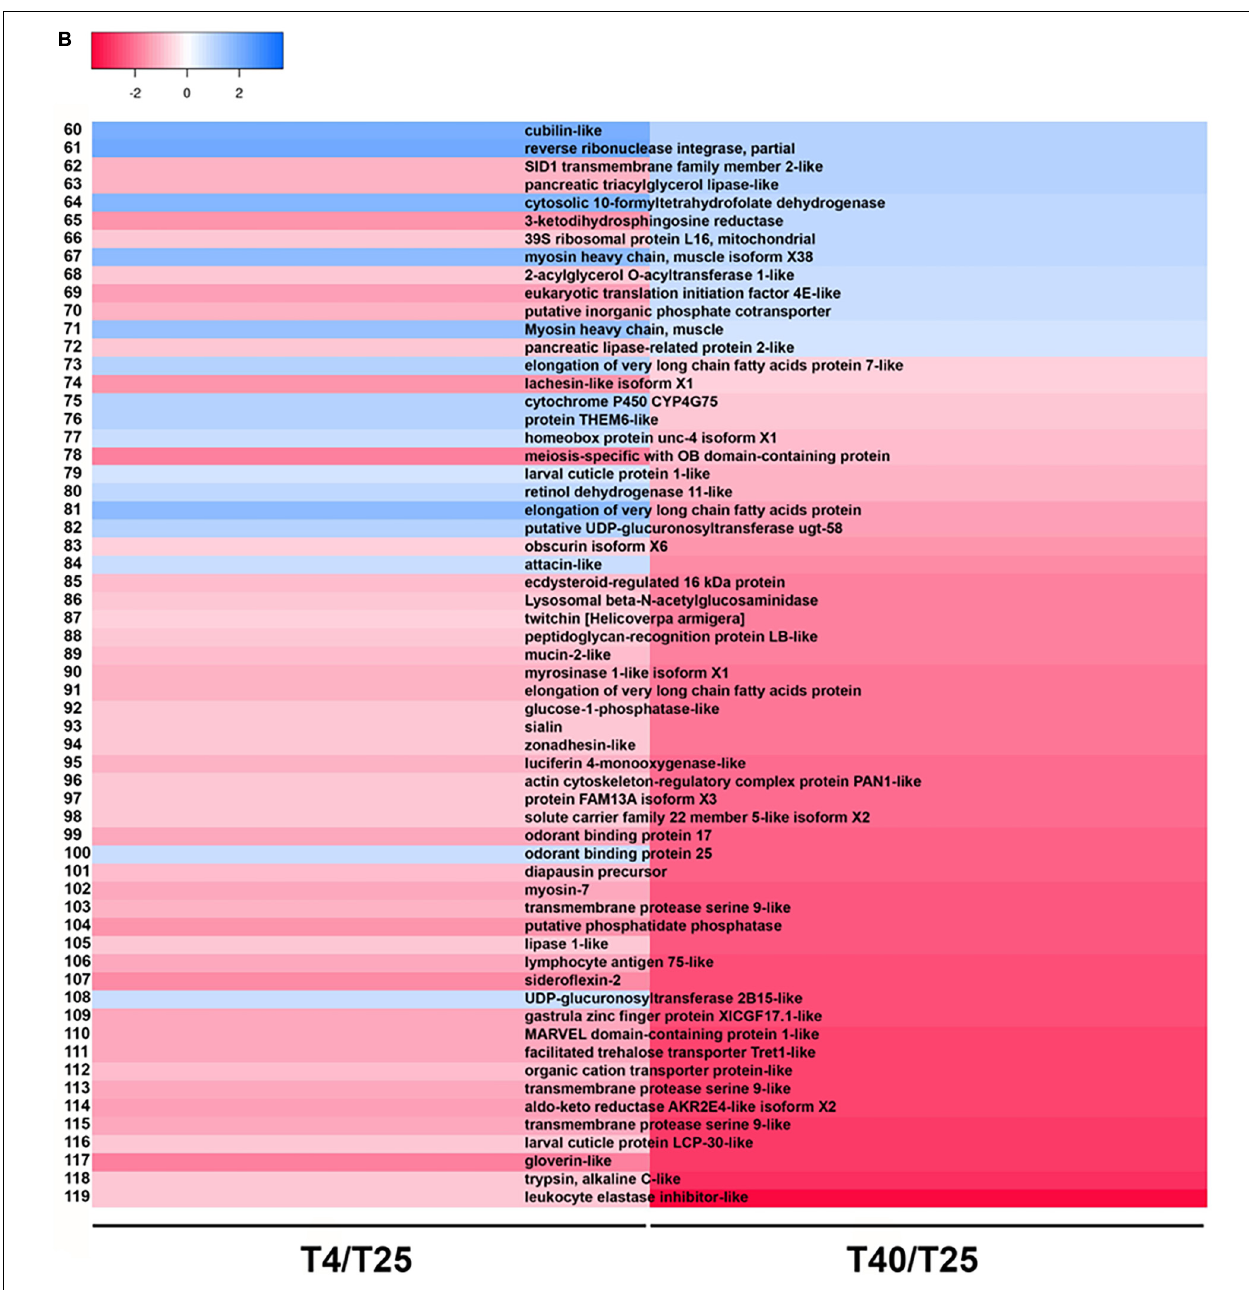
and NT), 14,338 (6.76%) and 33,699 (15.9%) unigenes